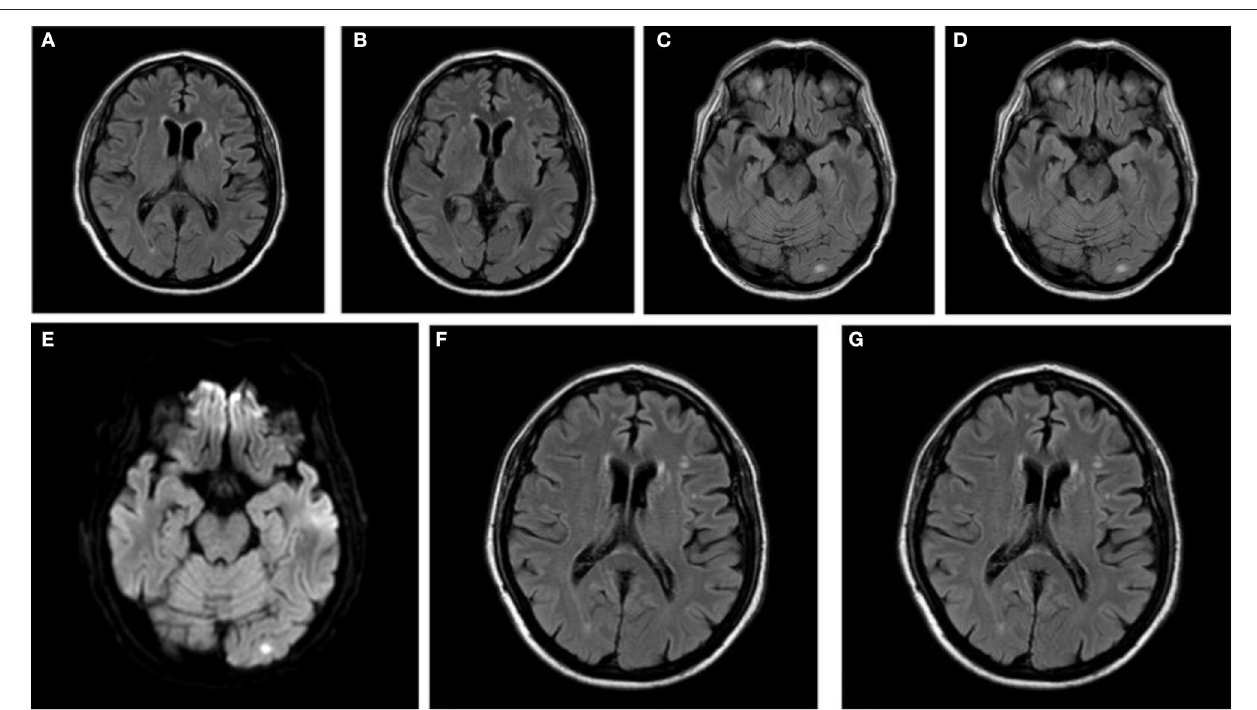
FIGURE 2 | Shoot from brain MRI of May 8 in ( A–E): (A,B) show T2-FLAIR acquisition. (C) Shows occipital lesion in T2-FLAIR acquisition. (D) Shows parietal lesion in T2-FLAIR acquisition. (E) Shows occipital lesion positive in DWI. Shoot from Brain MRI of June 16: (F,G) show T2-FLAIR acquisition.